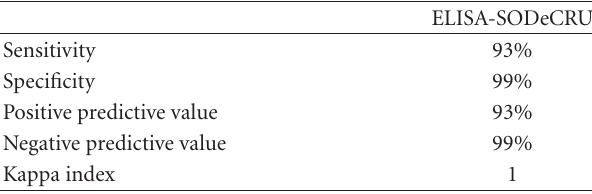
Table 2: Evaluation of the reliability to detect Trypanosoma cruzi antibodies, using ELISA technique with SODeCRU antigen, in 258 human sera from the suburban population in the city of Santiago de Quer´etaro (Mexico). The values given are estimated with Western Blot as the